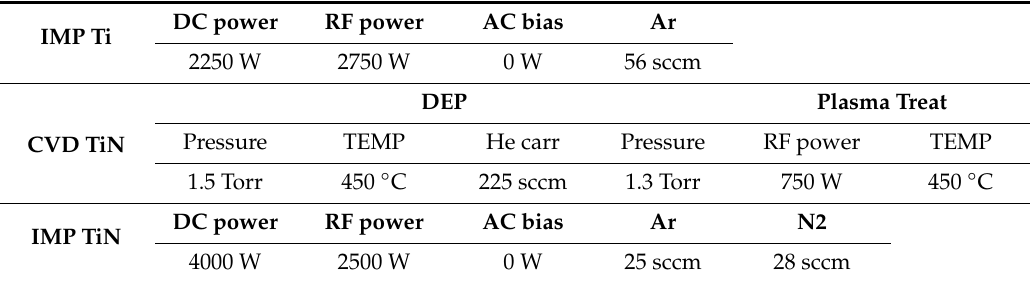
Table 2. Deposition conditions for each film.